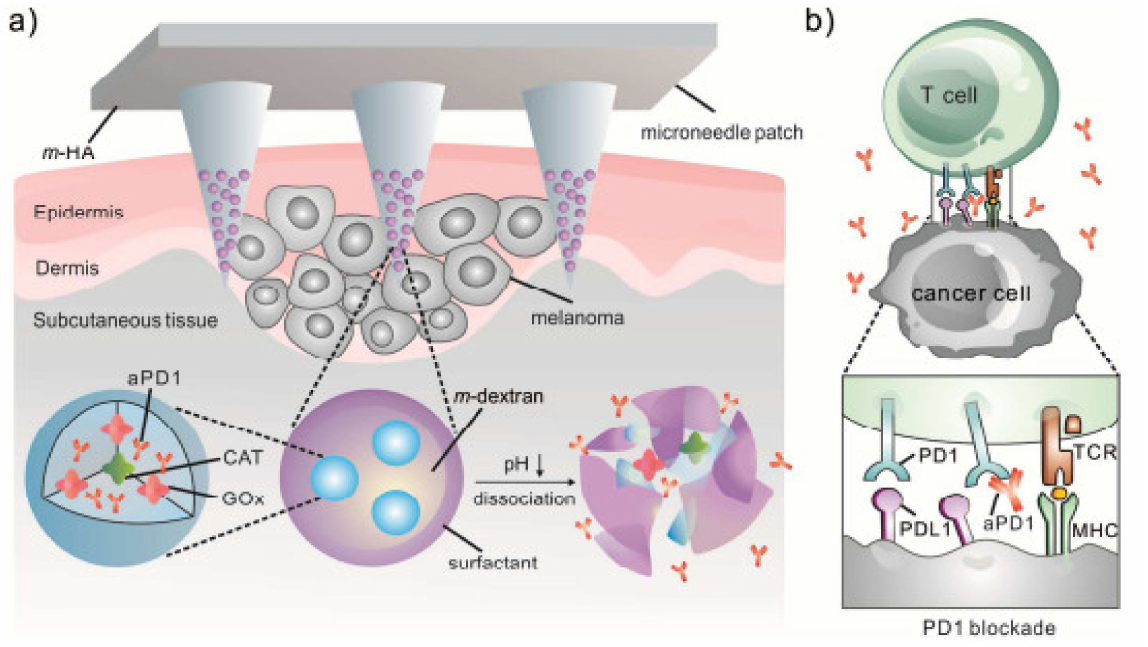
Figure 19. Biodegradable Hyaluronic acid MNs (HAMN) containing antibodies for the treatment of skin cancers. ( a ) Schematic of the aPD1 delivered by an MN patch loaded with physiologically self-dissociated NPs. ( b ) The blockade of PD-1 by aPD1 to activate the immune system to destroy skin cancer cells. [263]. (Reprinted with permission from Ref. [263]. Copyright 2016 American Chemical